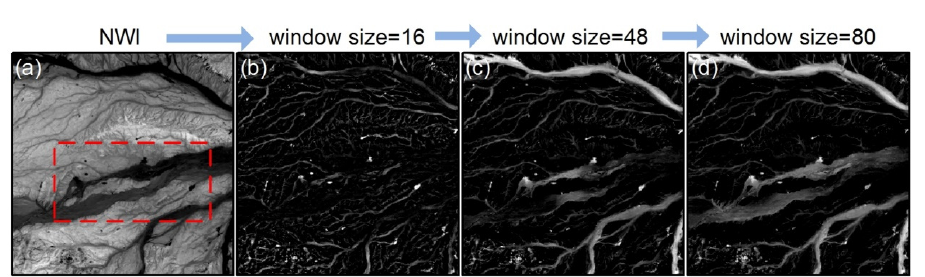
Figure 6. Results of neighborhood analysis: ( a ) NWI image; ( b ) window size = 16 pixels; ( c ) window size = 48 pixels; ( d ) window size = 80 pixels. The window sizes shown here are only used to provide a conceptual illustration of the application of the technique.